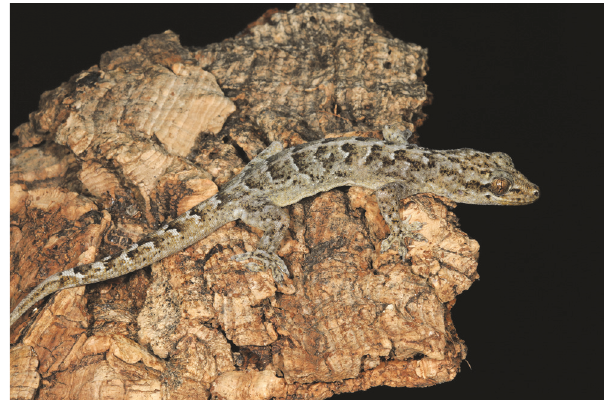
Figure 7: Coloration in life of the holotype (SMF 100949) of Phyllopezus heuteri